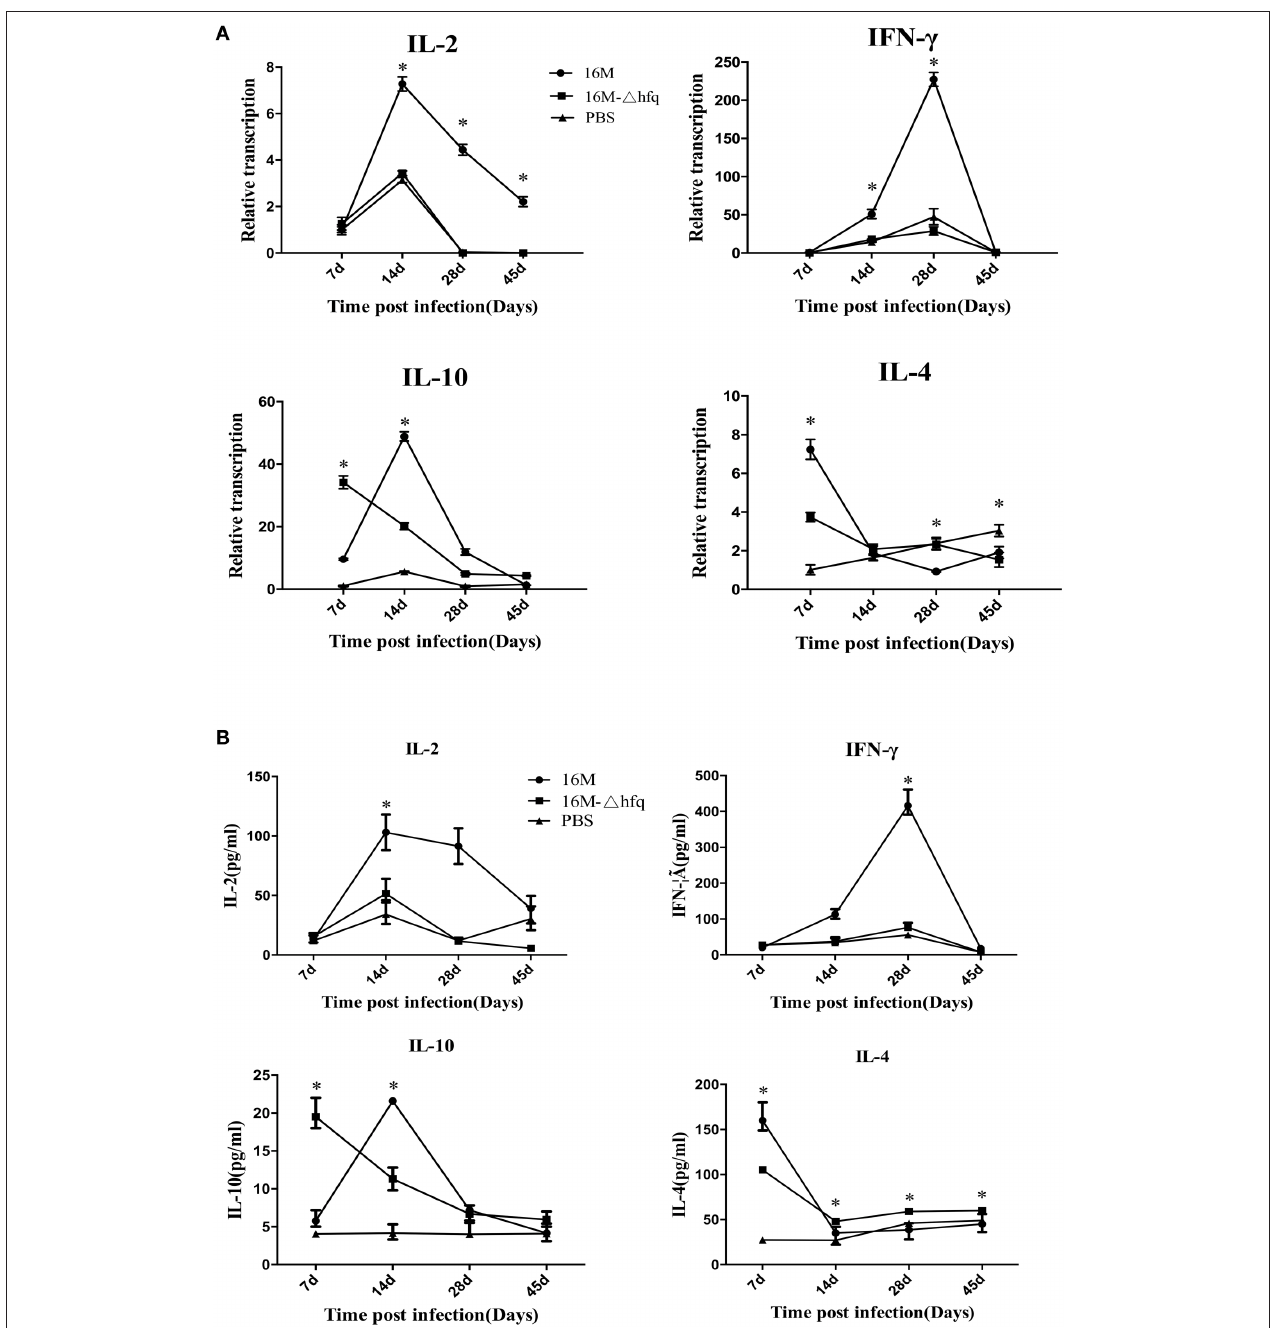
FIGURE 3 | Expression patterns of cytokine genes during Brucella infection. BALB/c mice were infected with B. melitensis 16M, 16M △ hfq, or PBS as negative control, and then RNAs were isolated from the spleens at 7, 14, 28, and 45 days post-infection. The relative transcription levels of IL-2 , IFN- γ , IL-4, and IL-10 , were determined by quantitative RT-PCR (A) . Secretions of the four cytokines were detected by indirect ELISA (B) . The data were compared to the expression level of PBS at 7 days. Significant differences between the mutant and parent strain were indicated as follows: * P < 0.001 .